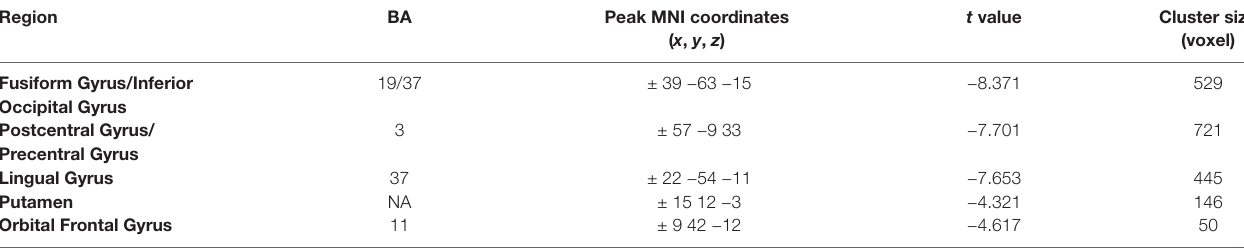
TABLE 2 | Regions showing significant differences in VMHC between OCD patients and HCs.